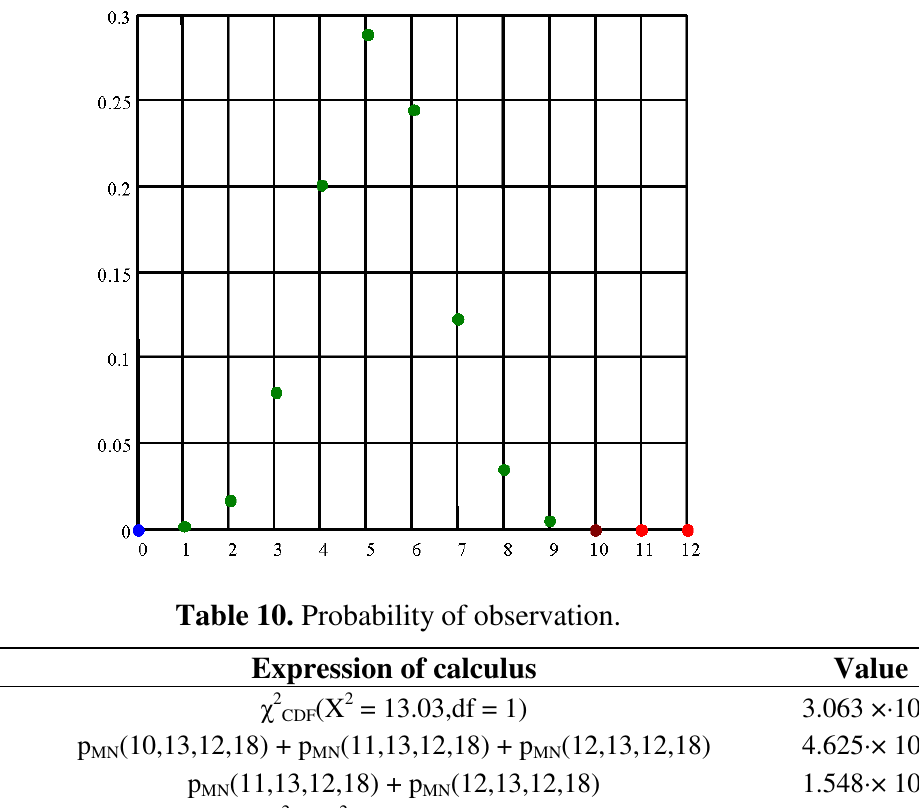
Figure 4. Value of the statistical probability of the observed according to the observable.